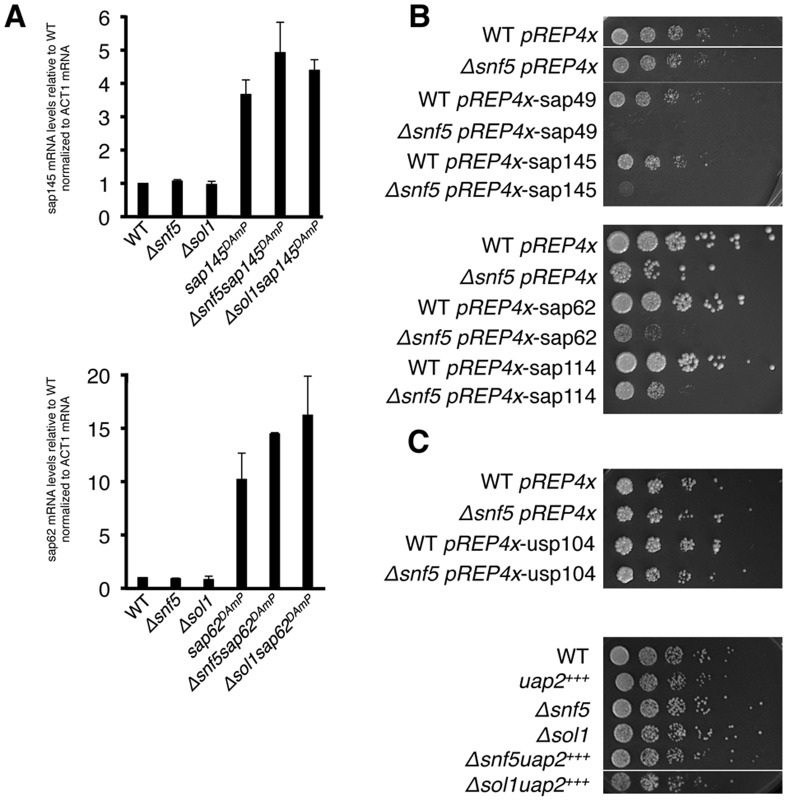
Overexpression of sap145 and sap62 is synthetic sick with SWI/SNF.(A.) RT-qPCR of sap145 and sap62 mRNA levels in single and double mutants strains. Bars represent fold change of sap145 or sap62 signal over WT, normalized to act1 mRNA. (B.) Serial dilutions (1:5) of WT and Δsnf5 ectopically overexpressing SF3b (top) and SF3a (bottom) factors grown at 30°C. (C.) Serial dilutions (1:5) of WT and Δsnf5 ectopically overexpressing usp104 (PRP40) (top) and DAmP overexpression of uap2(CUS2) crossed with Δsnf5 and Δsol1 (bottom).